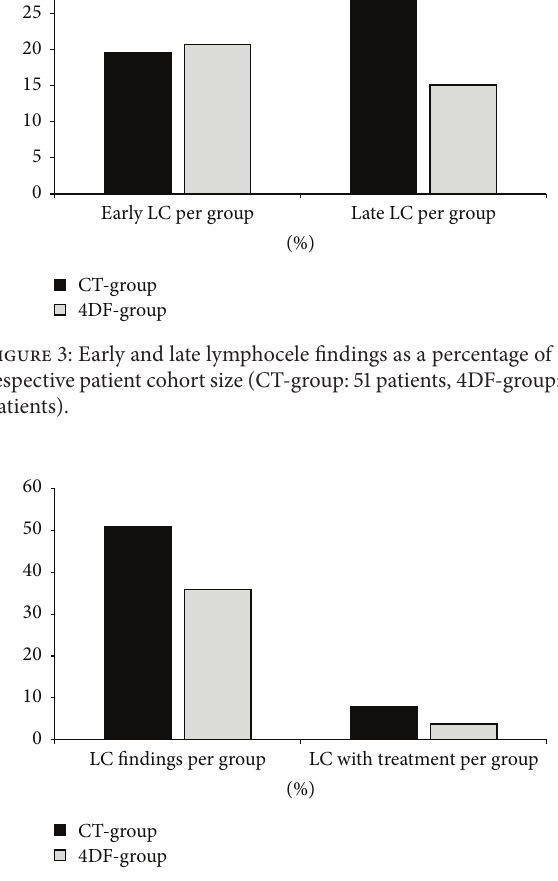
Table 4: Indication for drainage and LC volumes in controls and 4DF-group.